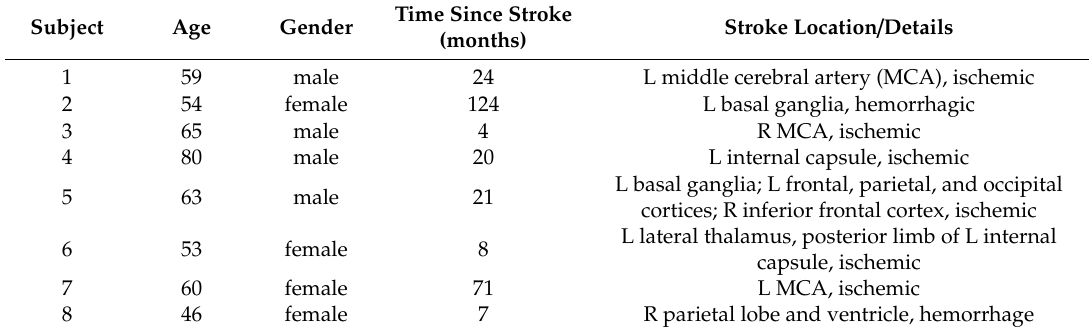
Table 1. Participant Characteristics.